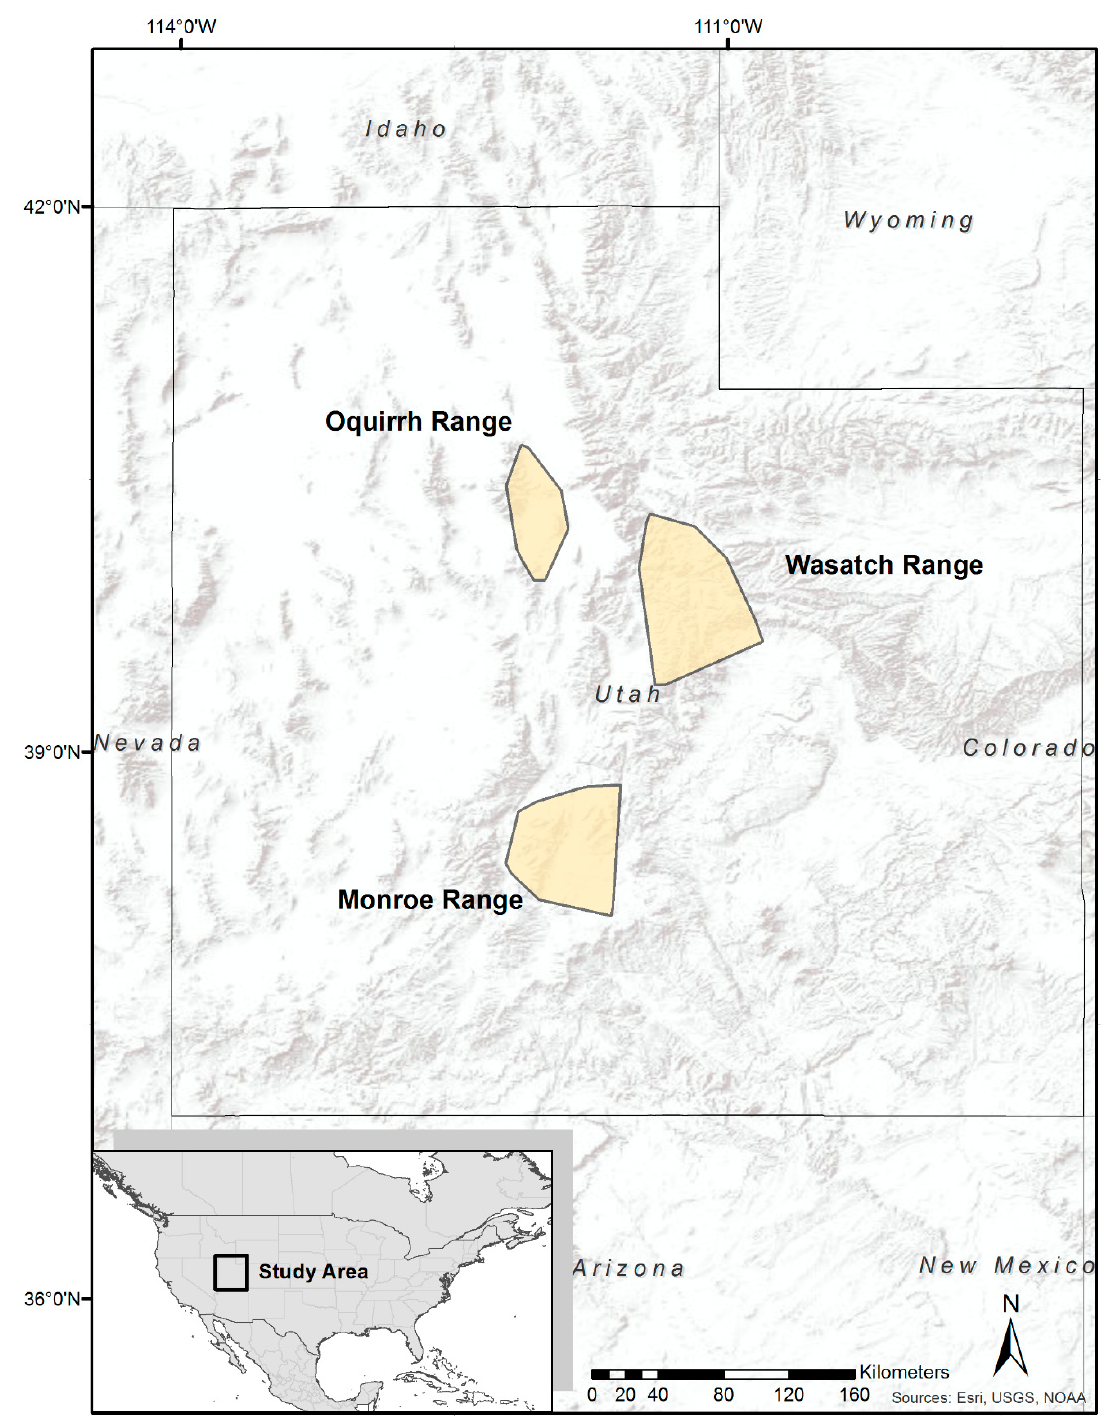
Figure 1. Study area. This study includes three distinct population ranges of mule deer. The Oquirrh range included 13 GPS-collared mule deer monitored between 2012 and 2014. The Monroe range included 14 GPS-collared mule deer monitored between 2012 and 2015, and the Wasatch range included 15 GPS-collared mule deer monitored between 2010 and 2012.